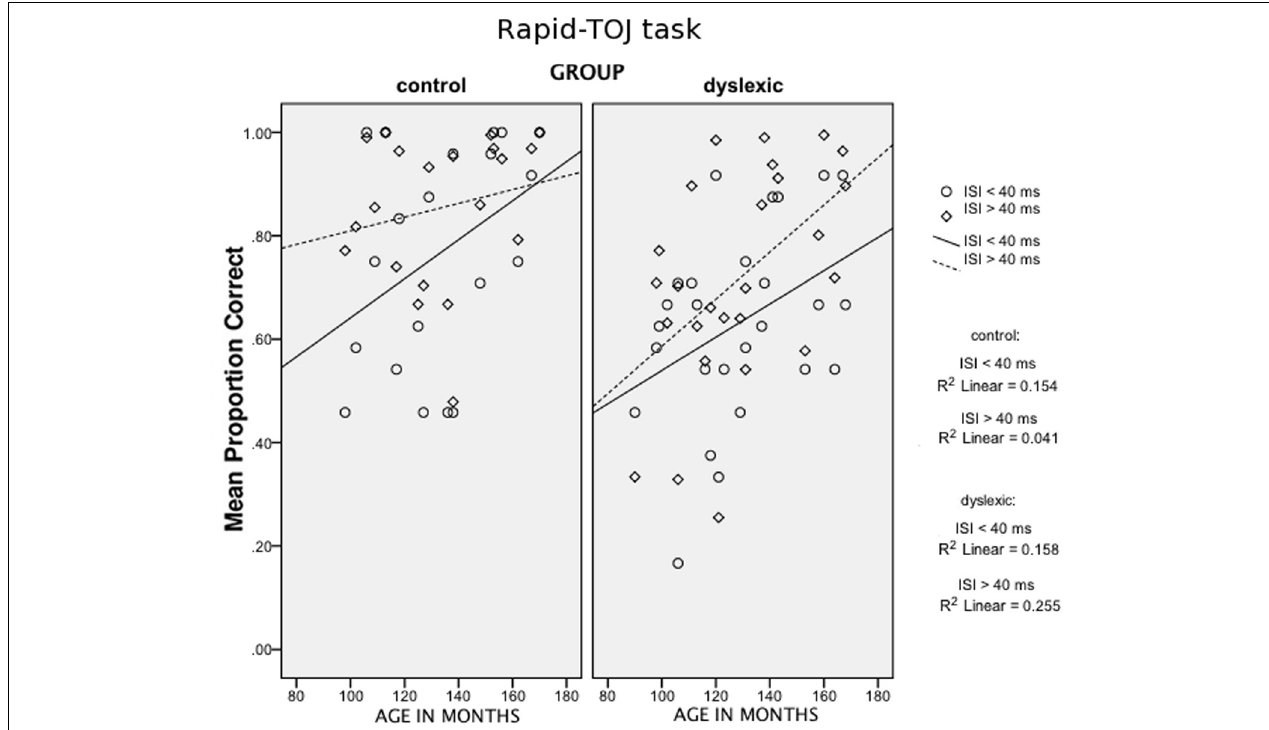
FIGURE 1 | Scatter plots of Age (in months, x-axis) against the mean proportion of correct answers in the Rapid-TOJ task (y-axis), for short and long-ISI conditions, for the two groups (control children and children with